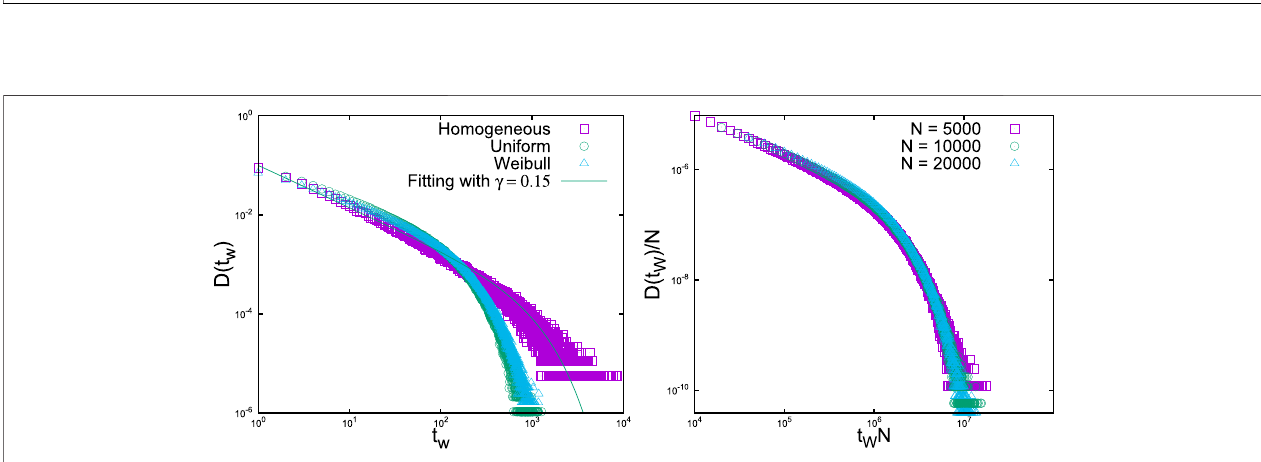
FIGURE8| Failuretimeversus σ (left)andversus T (right)forbundleshavinguniformstrengthdistributions.Thedataareforsimulationsover1000realizationswitha system size of N (cid:1) 10 6 , and the solid lines are the theoretical estimates following ( Eq. 56 ).